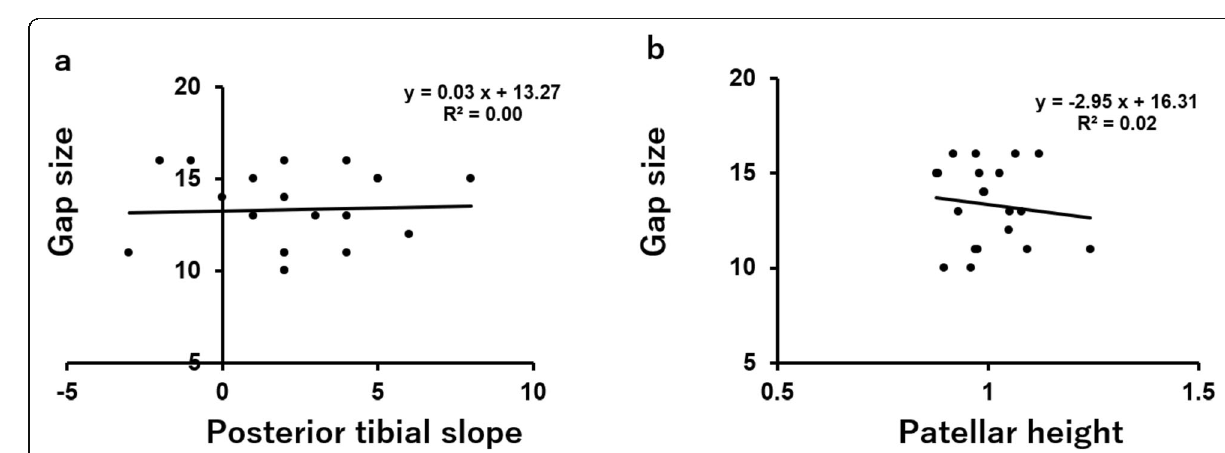
Fig. 5 The correlation between the flexion gap without the trial component and posterior tibial slope angle ( a ) or patellar height ( b )